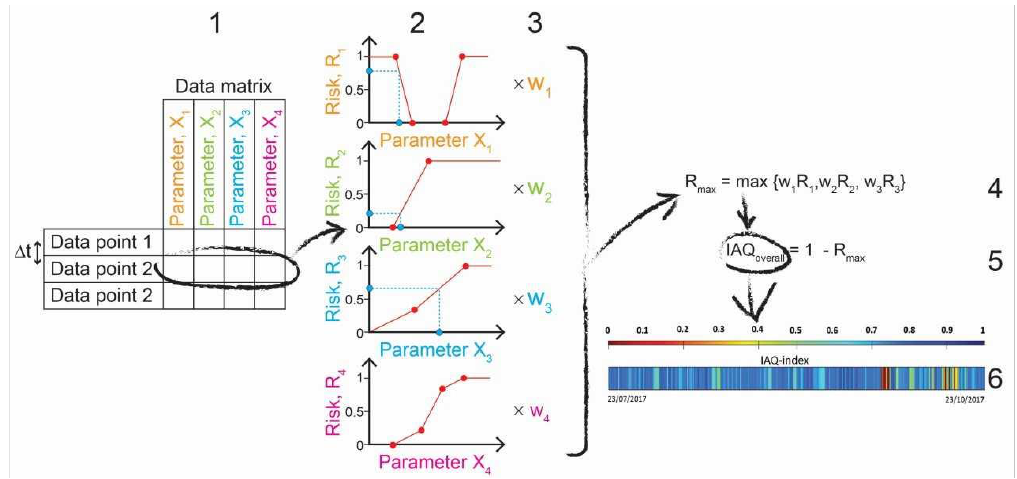
Figure Figure 4. Schematic visualisation of the steps considered by the indoor air quality (IAQ) index algorithm.